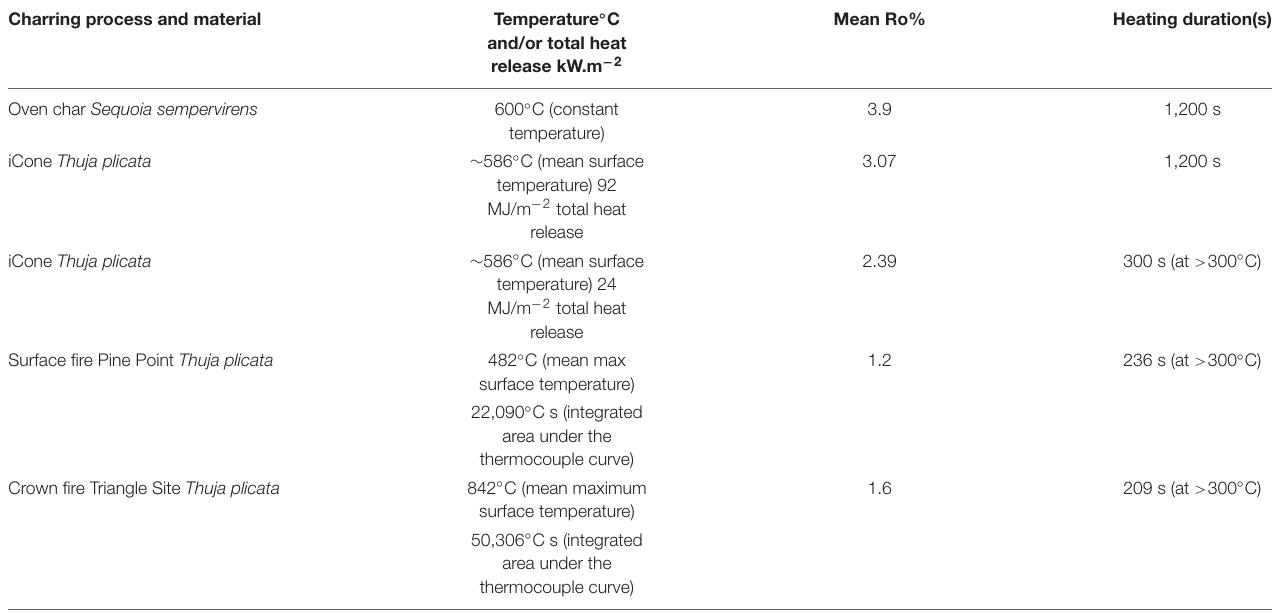
TABLE 1 | Comparison of charcoal reflectance and heating regimes for oven char (taken from Scott and Glasspool, 2007), and those generated in the laboratory and the field in this research. Charring process and material